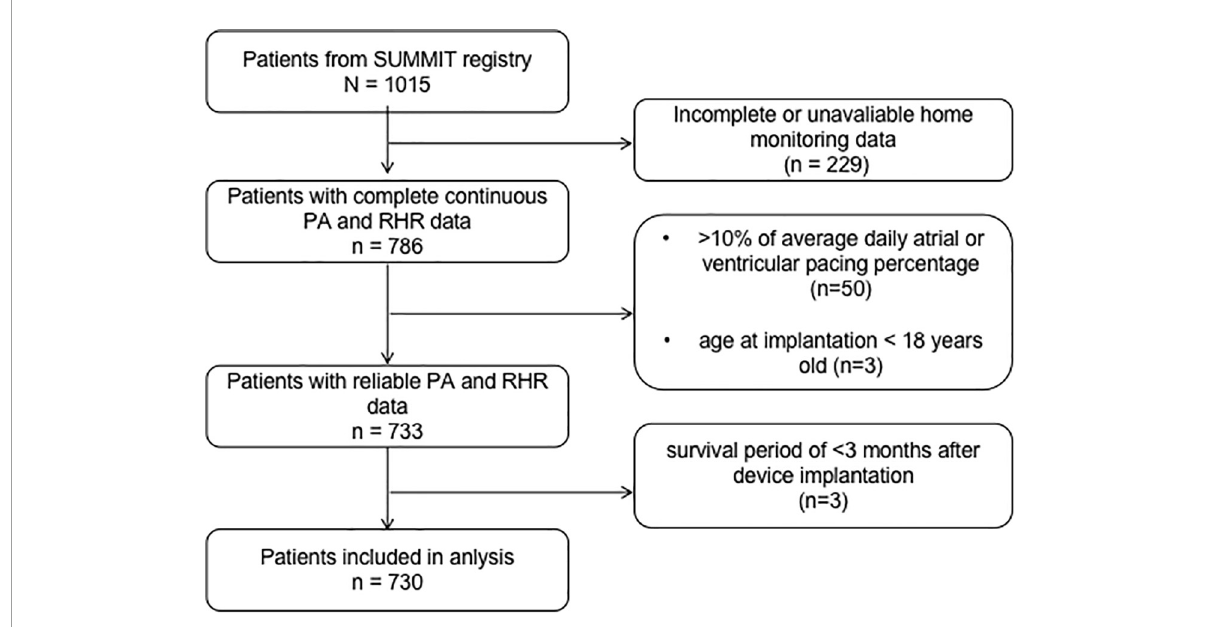
FIGURE2 Flow chart for patient selection. PA, physical activity; RHR, resting heart rate.